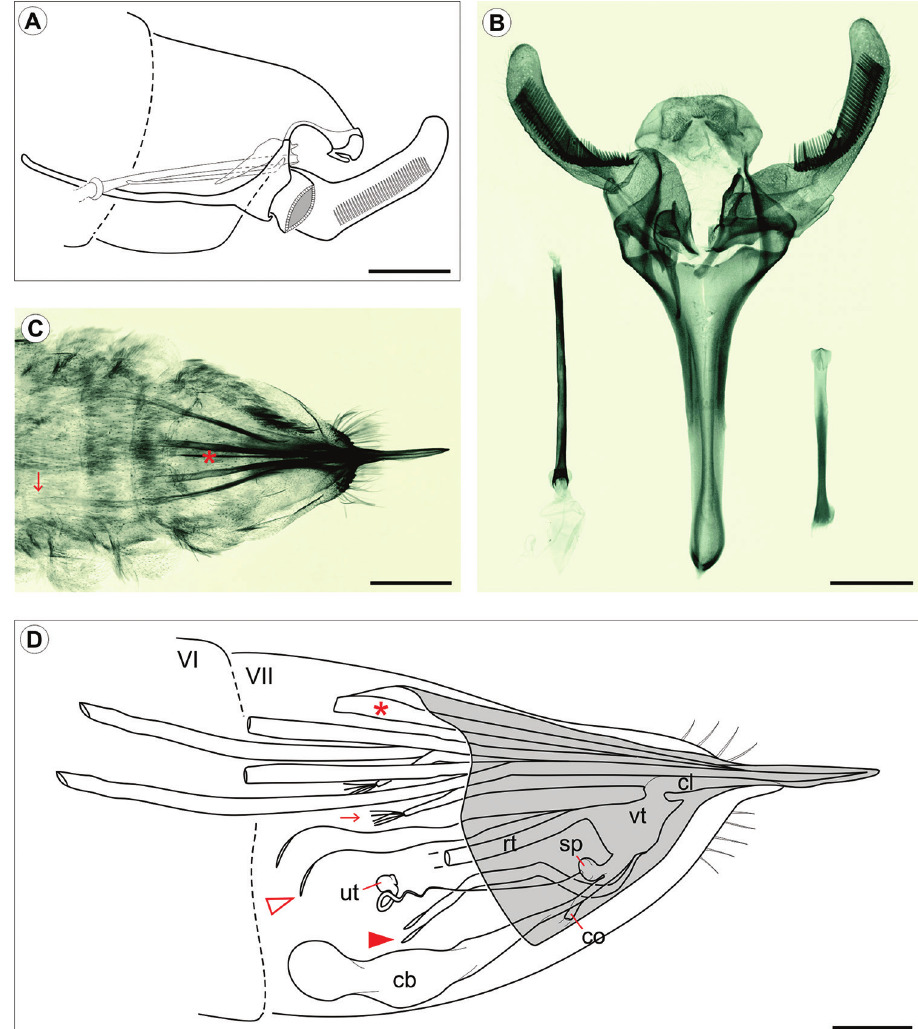
Figure 4. Cecidonius pampeanus genitalia morphology under light microscopy. A schematic representa- tion of male genitalia, lateral view (left valve omitted) B dissected male genitalia, ventral, with detached phallus and juxta, on left and right side, respectively C female genitalia, dorsal D schematic representation of female genitalia, latero-dorsal. Roman numbers indicate abdominal segments. Oviscapt cone is repre- sented in light gray in D . Arrows point to the end of left anterior apophysis in C , and to the apodeme of posterior apophysis in D . Asterisks indicate internal dorsal crest of oviscapt cone in C and D . Open and closed arrow heads point, respectively, to posterior apophyses and cloacal apodemes in D . Abbreviations: cb corpus bursae; cl cloaca; co common oviduct; sp spermatheca; rt rectum; vt vestibulum; ut utriculus of spermatheca. Scale bars: 0.25